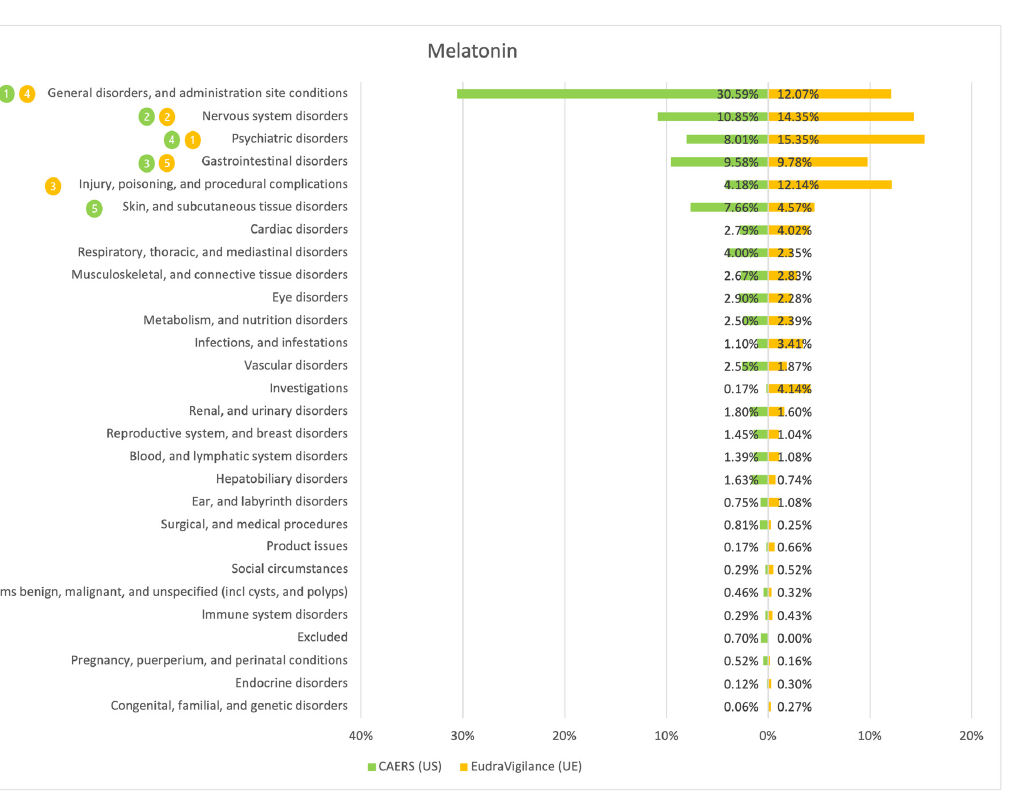
Figure 1. Summary of the frequency of reporting side effects of Melatonin in the US and EU registers. Data marked in green refer to the CAERS (US) database and yellow to the EudraVigilance (UE) database. Numbers 1–5 present the most commonly reported categories of adverse effects in descending order.